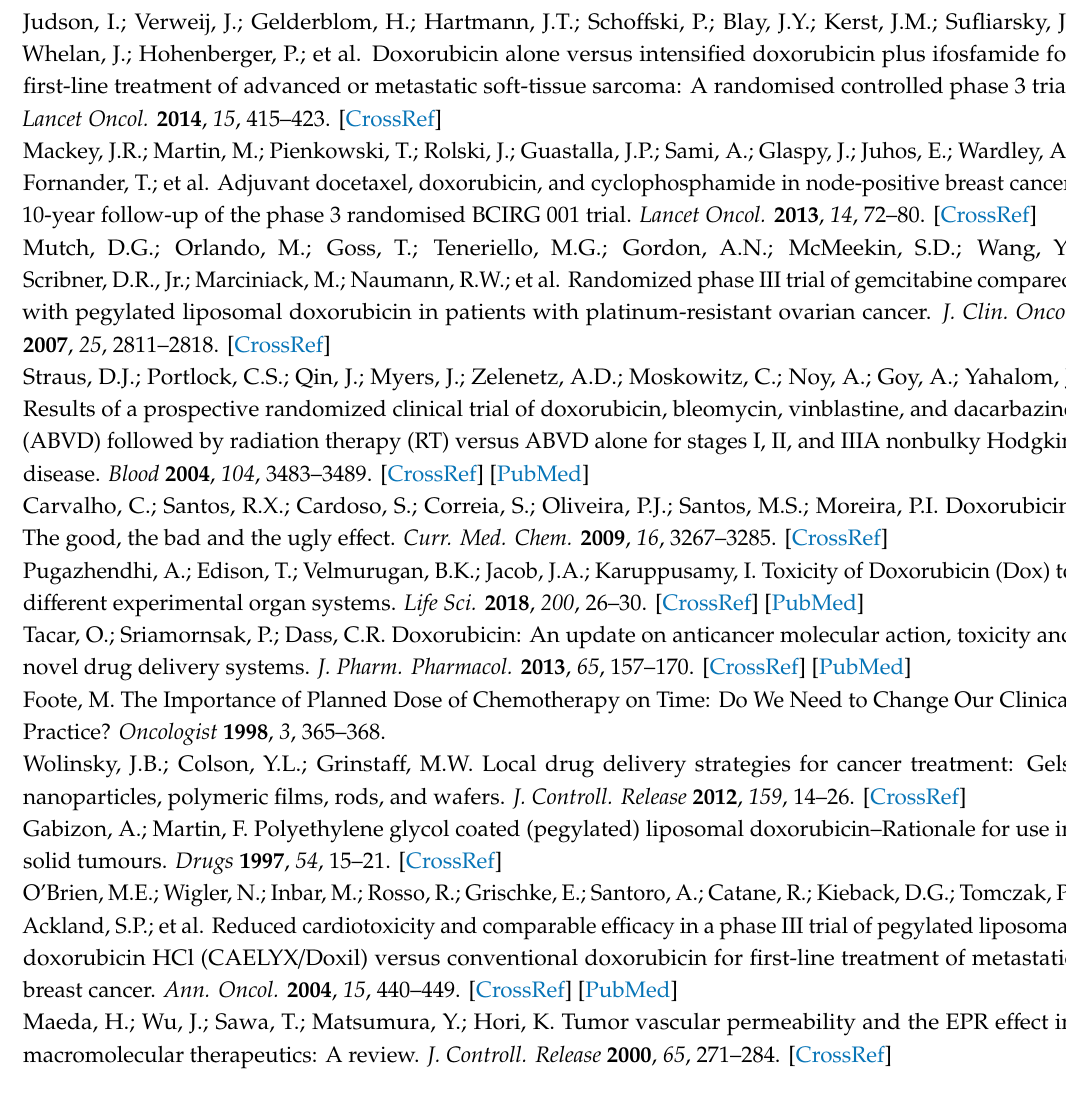
Figure S1: Di ff erent stainings of tumors treated with DOX of 2.5, 5 and 10 mg / kg, Figure S2: Di ff erent stainings of tumors treated with DOXIL of 2.5, 5 and 10 mg / kg, Figure S3: Di ff erent stainings of tumors treated with ThermoDox of 2.5, 5 and 10 mg / kg, Figure S4: Doxorubicin intensity relative to the perfused vessels in locations with high and low doxorubicin intensities, Figure S5: Experimental timeline of the experiments, Figure S6: Hyperthermia setup, Figure S7: Calculations of Hdox over the whole tumor and doxorubicin intensity in relation to the perfused vessels, Figure S8: Total tumor and zoomed in detail of the stainings of the tumor treated with 5 mg / kg ThermoDox; doxorubicin (A), Perfusion (B), All vessels (C), hypoxia (D) and dividing cells (E). The scale bar in the total tumor represents 1 mm. The size of the zoom is 1.43 × 1.43